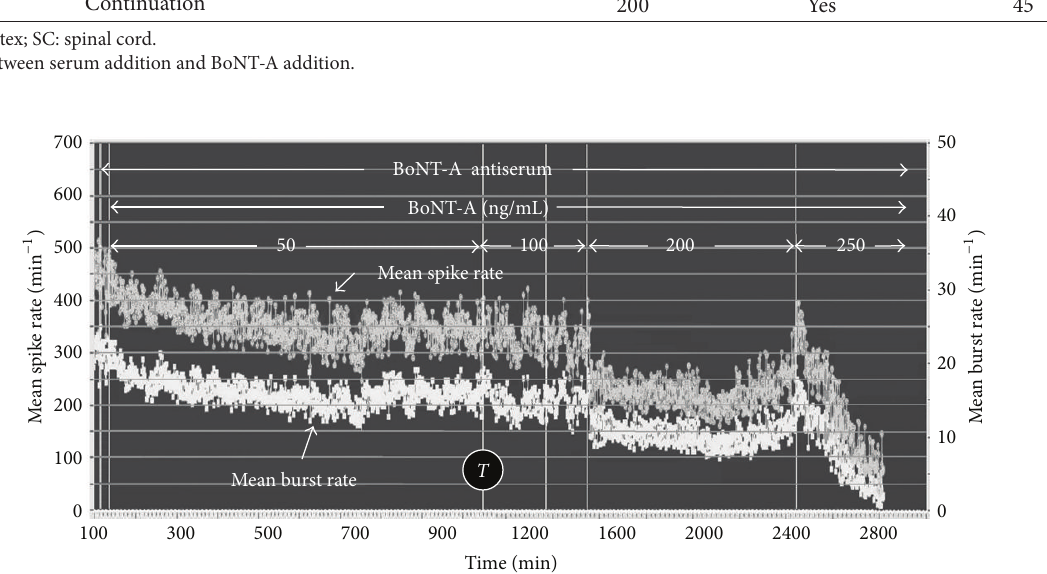
Figure 7: Protection of a frontal cortex network activity with antisera pretreatment. BoNT-A (50 ng/mL) was added 20 min after application of 2% antiserum. The network maintained spontaneous activity for 40hrs despite increases in BoNT-A concentrations from 100 to 200 ng/mL. Activity was finally stopped by 250 ng/mL. Without the antiserum, 90% of the activity would have been lost at 300 min (white arrow). 𝑇 : time base switch from 1min to 2